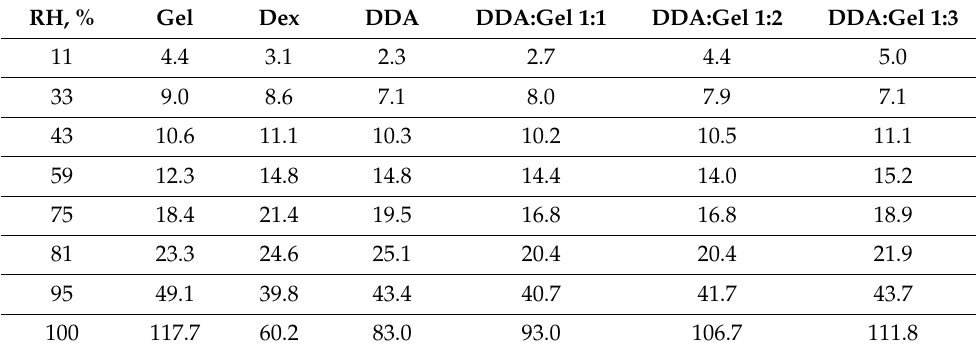
Table 1. Equilibrium moisture content (g/100 g) of cryogels at different relative humidities (RH). ±S.D. did not exceed 3%.